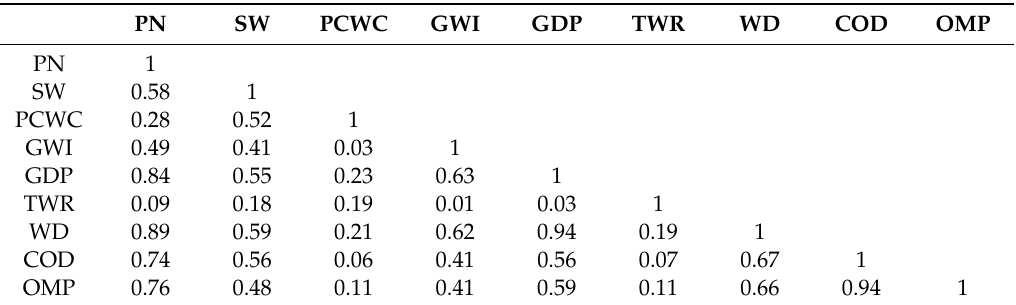
Table 4. Correlation matrix of principal component regression (PCR) in China’s provinces for the